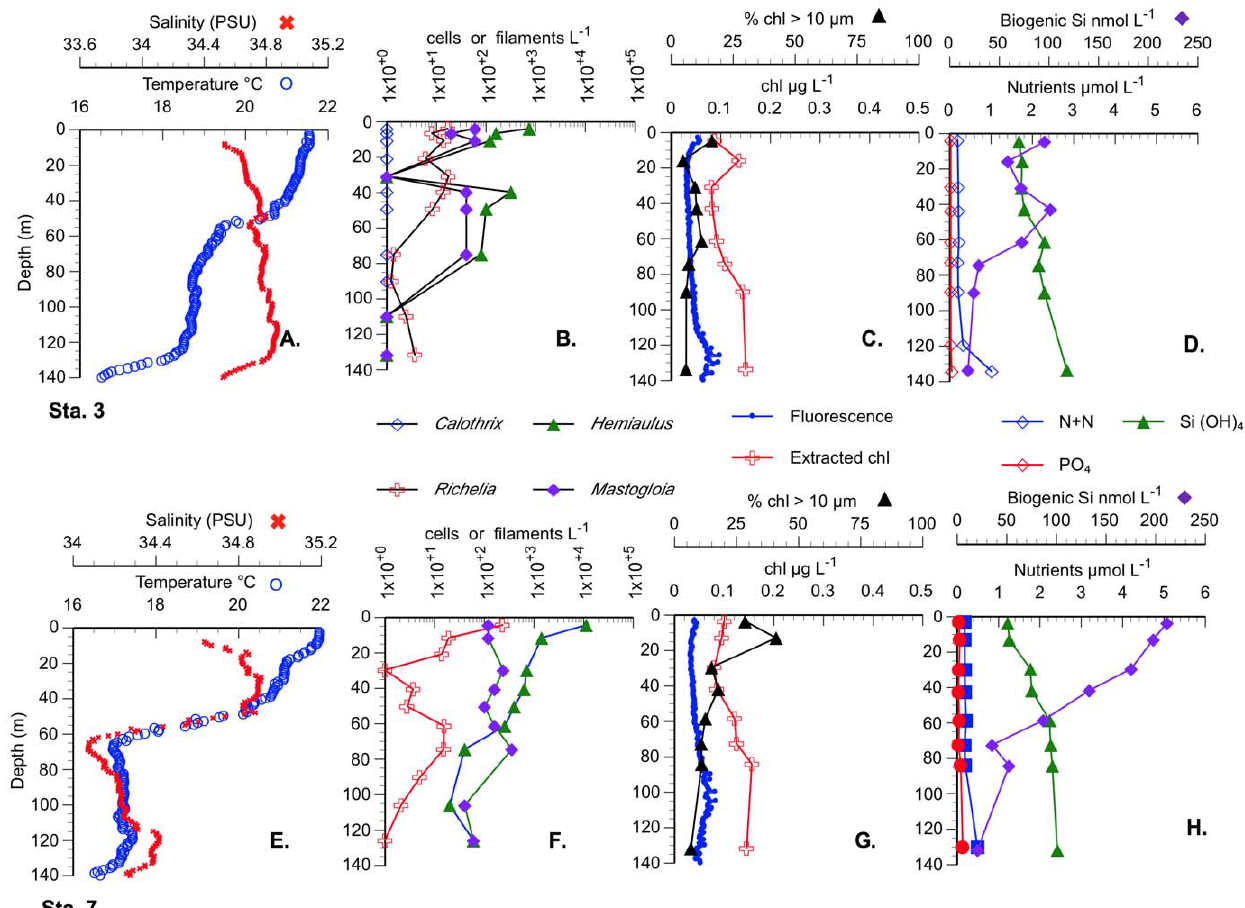
Figure 4. Comparison of two stations within the 2008 chl bloom. Vertical profiles of Sta. 3 &7 in 2008. A-D Station 3 (representative station), E-H Sta. 7 (highest abundance station). A, E. Temperature and Salinity CTD profiles. B, F. Cell and symbiont counts. C., G. Chl a . (CTD fluorescence, extracted and % . 10 m m). D., H. Nutrient and biogenic silica concentrations.